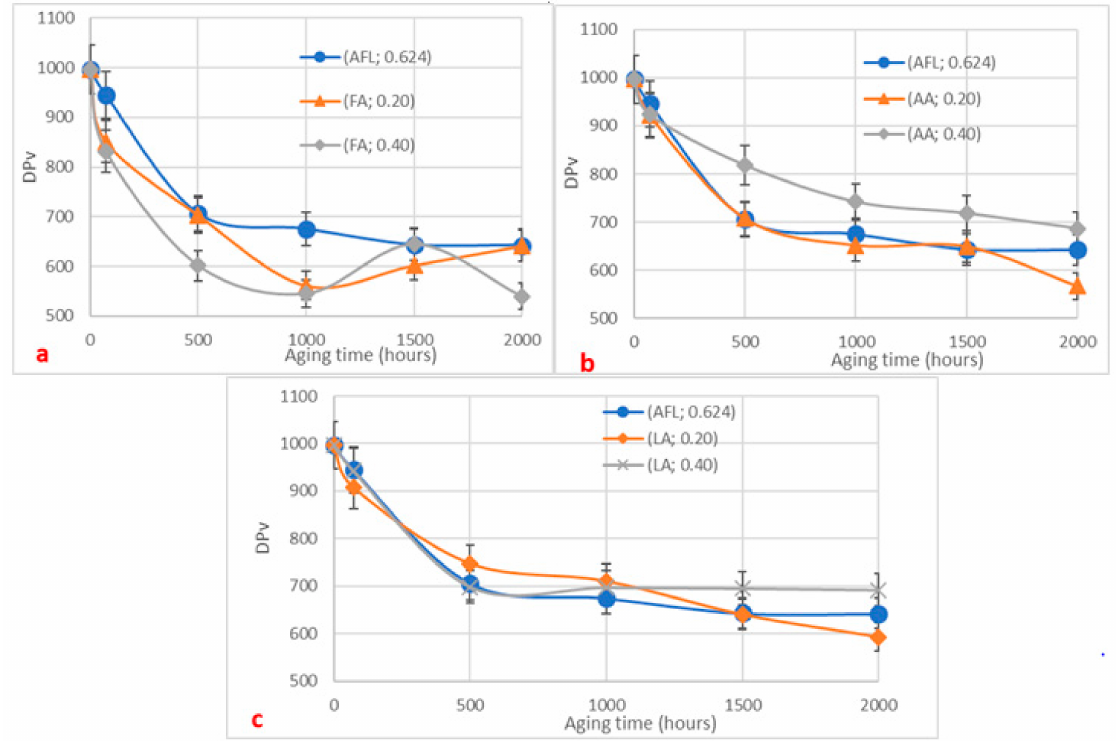
Figure 6. Degree of Polymerization (DPv) of paper as a function of aging in oil blended with acid mixture of 0.624 mg KOH/g, compared to samples aged in three different acids (formic, acetic and levulinic): ( a ) 0.20 mg KOH/g and ( b ) 0.40 mg KOH/g for three different acids (formic, acetic